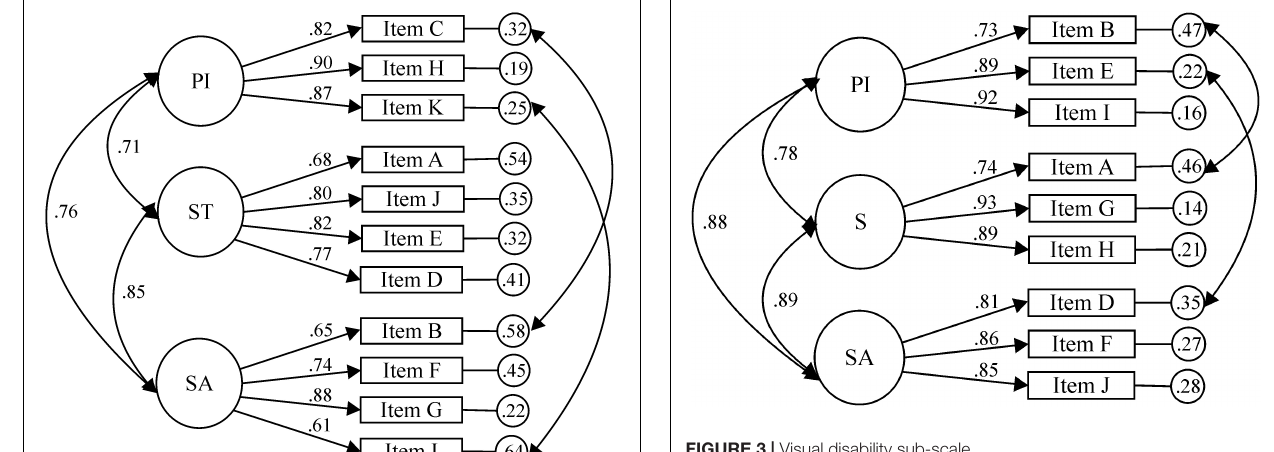
FIGURE 3 | Visual disability